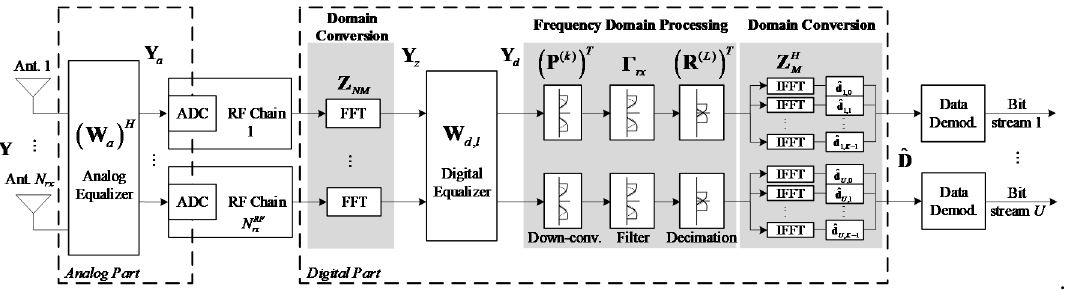
Figure 2. Block diagram of the receiver. ADC (analog to digital converter).